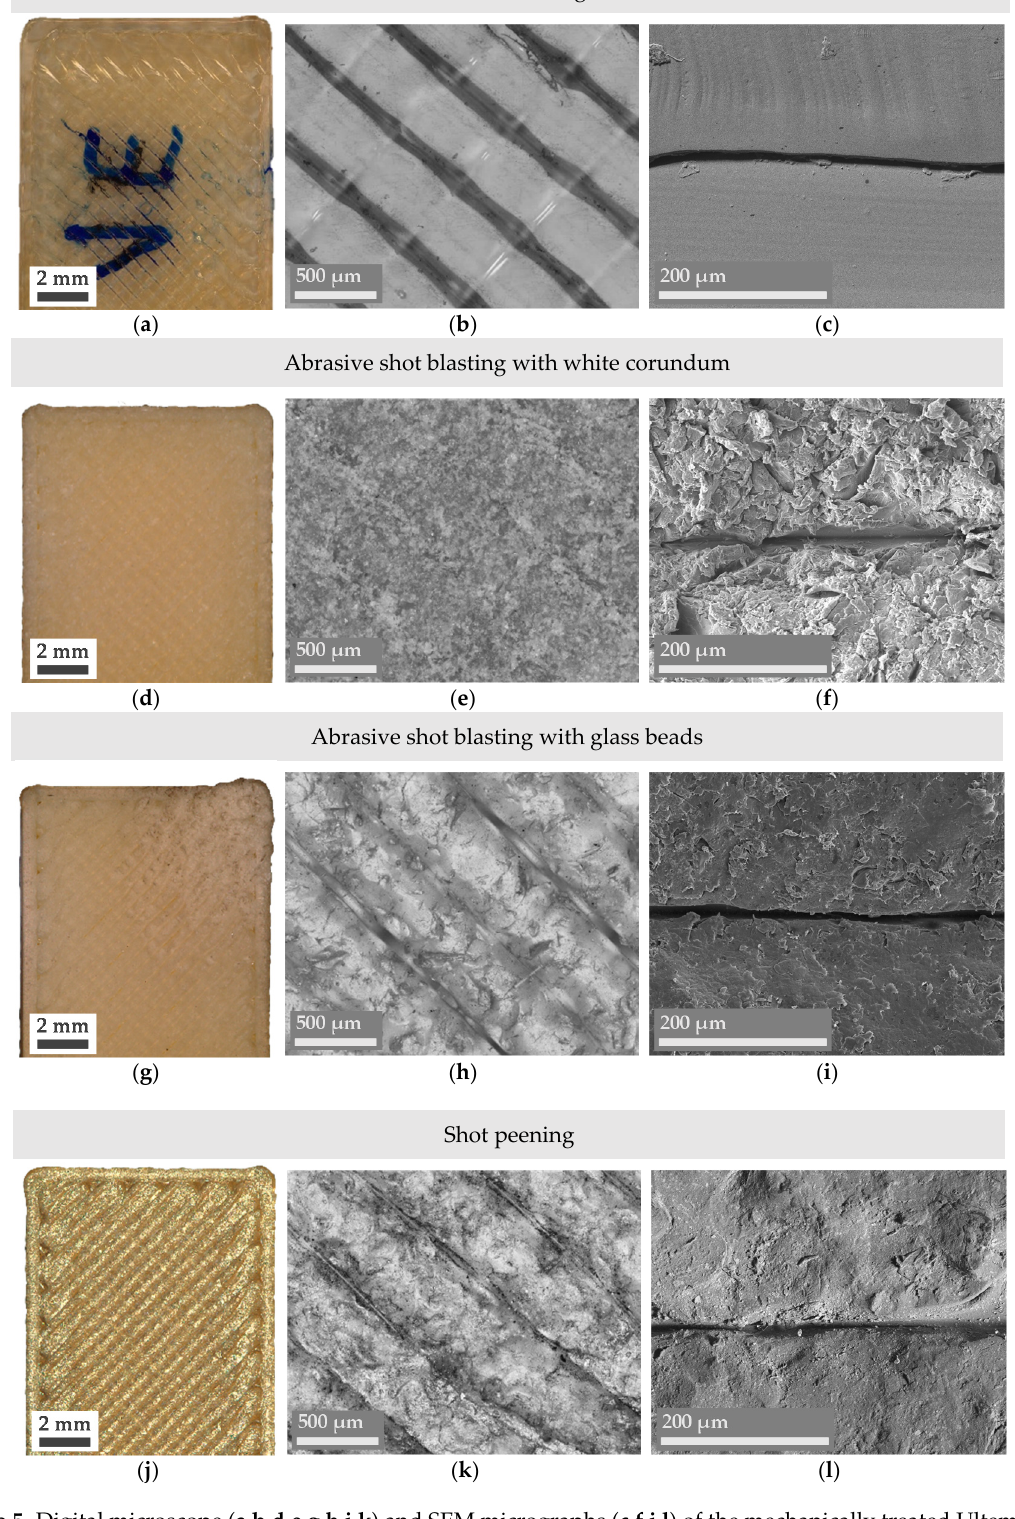
Finally, microscopy images from the shot peened samples (Figure 5j–l) show a shinier